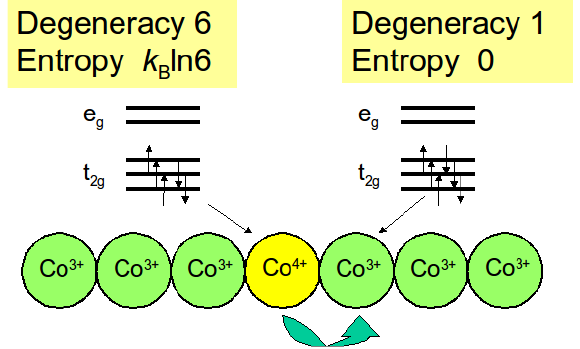
Figure 1 . Schematic drawing for the explanation of conduction mechanism of the cobalt oxide proposed by Koshibae et al .